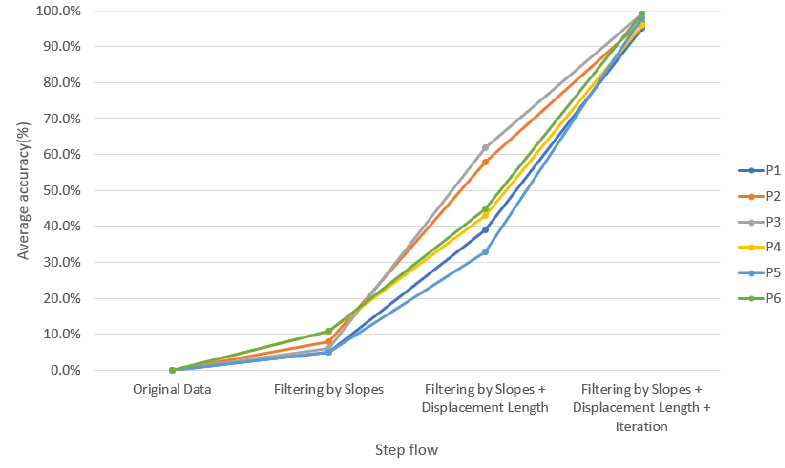
Figure 7. Average accuracy of each step for six subjects. (P1–P6 mean subjects 1–6).